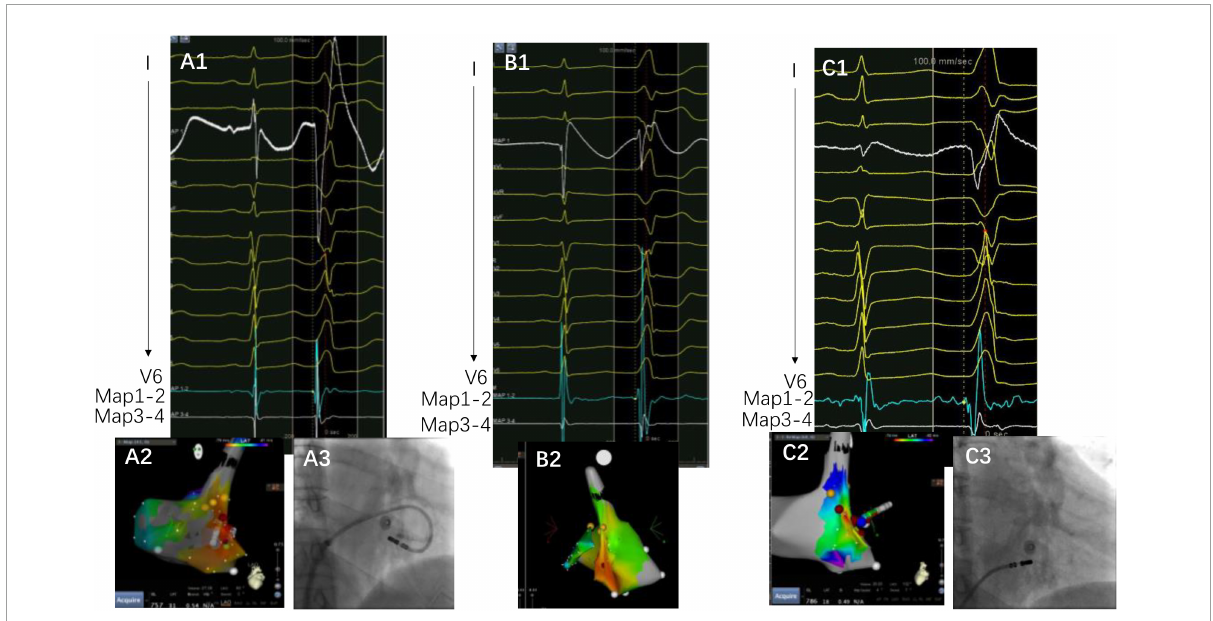
FIGURE3 A case of VAs ablated from the low Koch’s triangle. Panels (A1–A3) are target activation, three-dimensional map, and fluoroscopy image at the under-valve area, respectively. The target electrogram precedes the QRS onset by 14 ms, with a small “a” signal at the target electrogram. Panels (B1,B2) are the earliest activation and three-dimensional map, respectively. Notice that the target electrogram has a 6 ms prematurity compared with QRS onset without the “a” potential. Panel (C1) is the target electrogram at the low Koch’s triangle preceding QRS onset with 28 ms. There is also an “a” potential at the target. The yellow points depict the area recording His in Panel (C2) and the blue point depicts the mapped activation. Notably, QRS demonstrates subtle changes after ablation on the right side of the under-valve area. Panels (A3) and (C3) depict the image contrast of the under-valve area and above valve area (low Koch’s